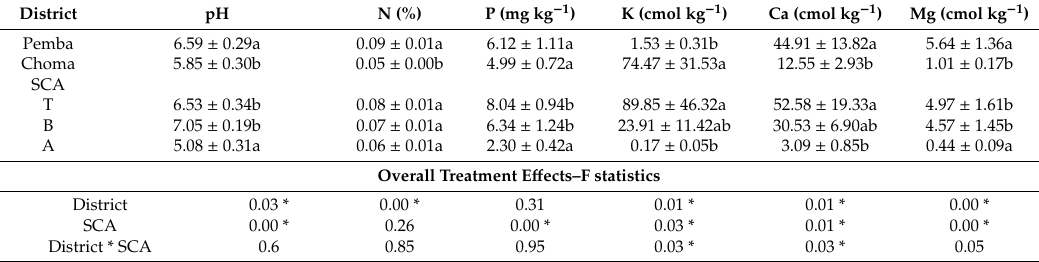
Table 2. Comparison of soil chemical parameter values and treatment e ff ects across studied